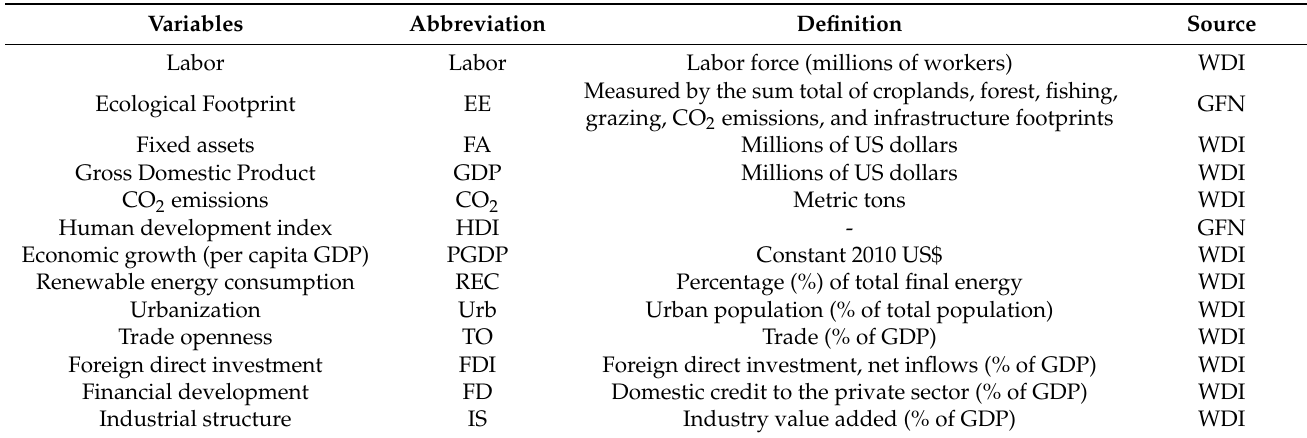
Figure 1. The five sub-regional blocs in Africa. Table 1. Variable